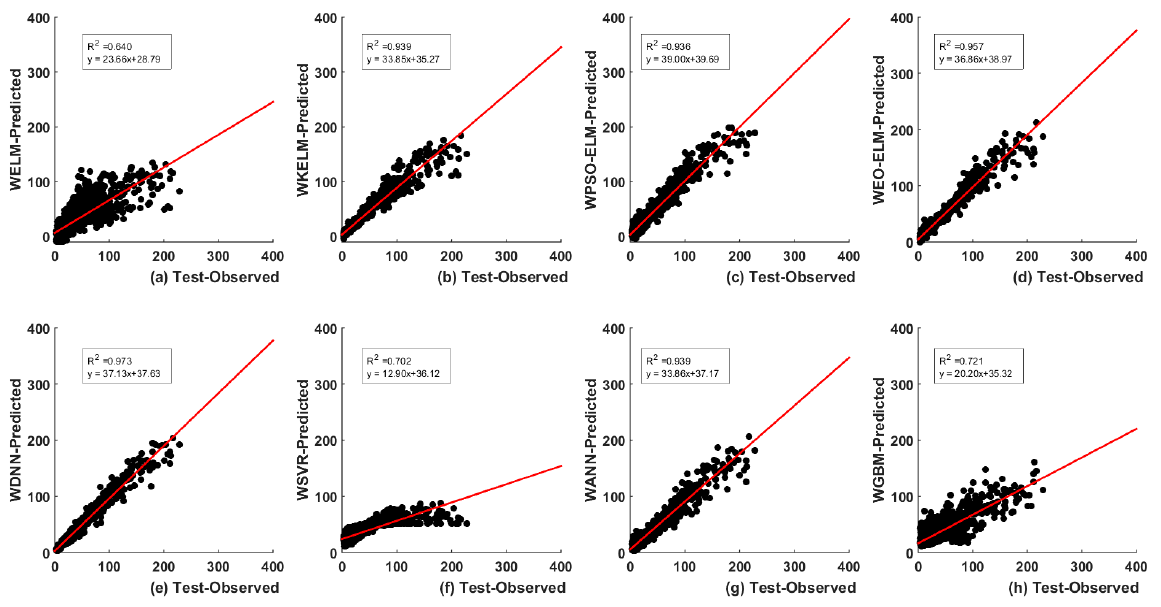
Figure 18. Prediction capability of the eight models in test case ( a ) WELM, ( b ) WKELM, ( c ) WPSO-ELM, ( d ) WEO-ELM, ( e ) WDNN, ( f ) WSVR, ( g ) WANN, and ( h ) WGBM for the catchment Teifi at Glanteifi.